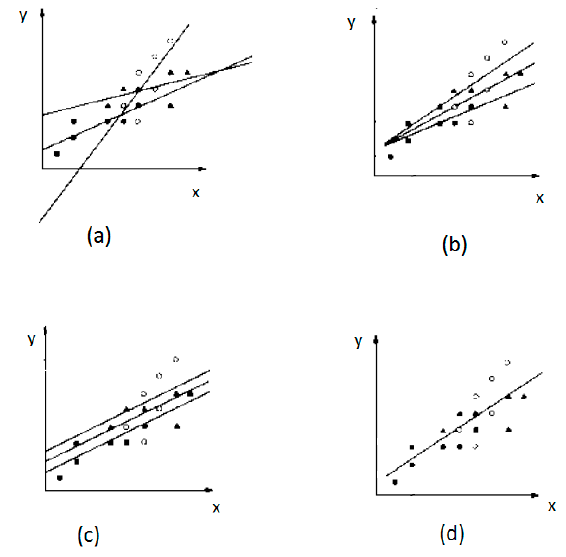
Figure 1. Relation between regression lines. ( a ) Completely different; ( b ) intercept (same intercepts); ( c ) parallel (same slope but without intercept); and ( d ) coincidence (exactly same lines) [12].